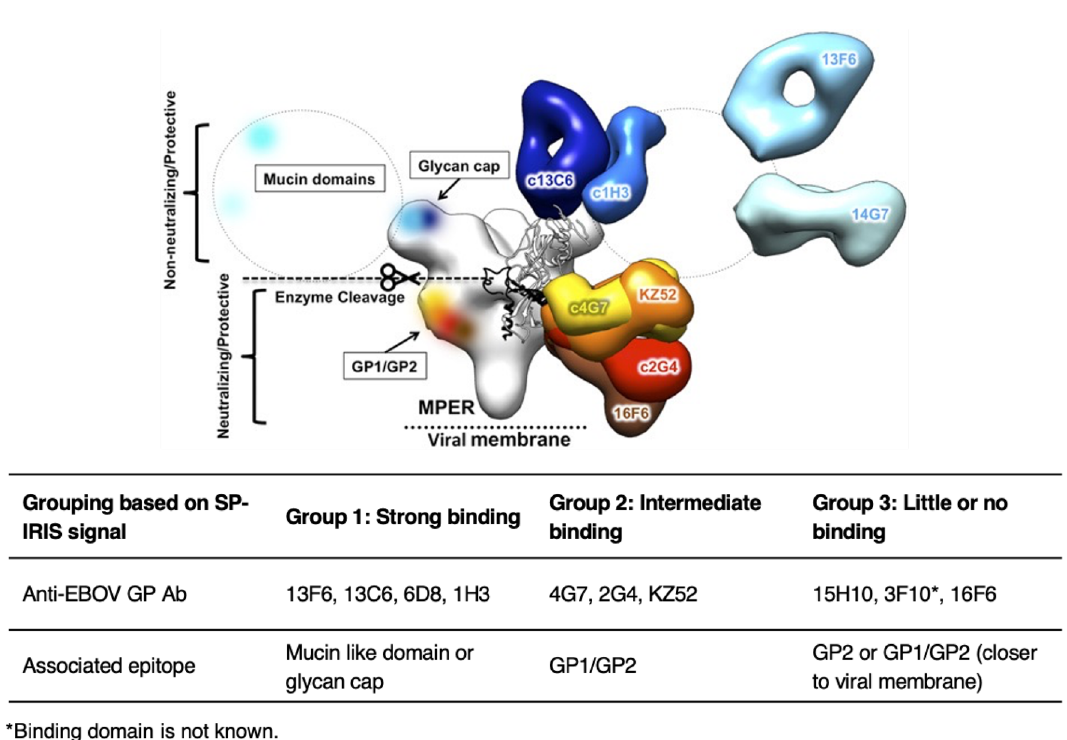
Figure 3. Anti-EBOV GP antibody epitope mapping based on SP-IRIS data. Top image shows the epitopes for protective mAbs on the EBOV GP structure. Reproduced with permission from 32 . The bottom table shows the grouping of mAbs against Ebola virus GP based on their signal levels on SP-IRIS. Group 1 antibodies show the highest level of binding on SP-IRIS with binding sites either on the mucin-like domain or glycan cap, the most accessible areas on the GP for binding. Group 2 antibodies have intermediate binding levels on SP-IRIS and they bind to the GP1/GP2 interface of the GP in the base domain. Group 3 antibodies show little or no binding on SP-IRIS. These antibodies bind either to the base domain with a steeper angle than the Group 2 antibodies or MPER region which is the region of the GP that is the closest to the viral